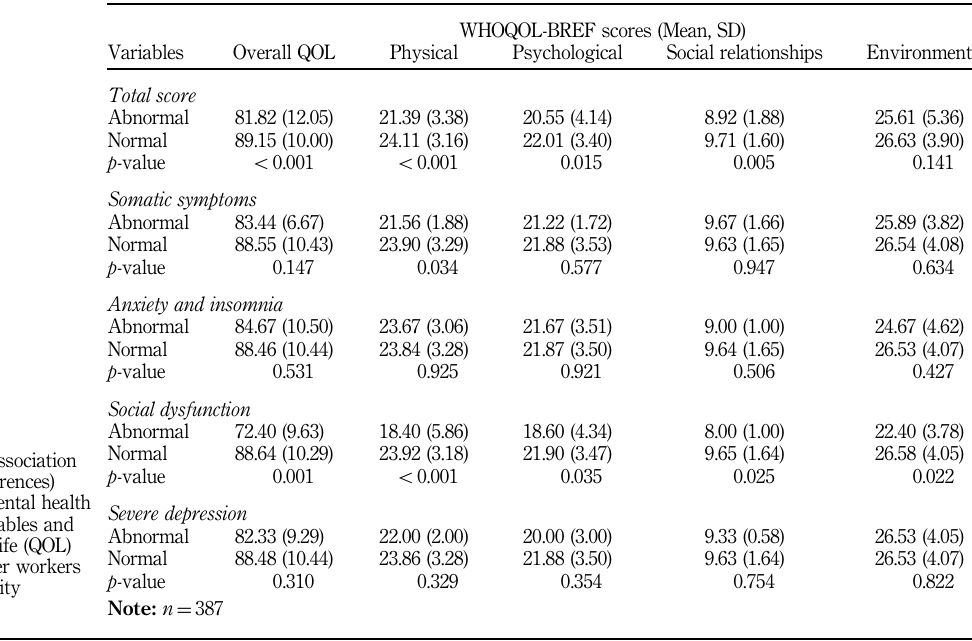
were significant predictors for QOL of older workers ( p -value o 0.001). These two predictors explains 11.8 percent of the influence on QOL of older workers. ( F ¼ 15.53, p o 0.001,